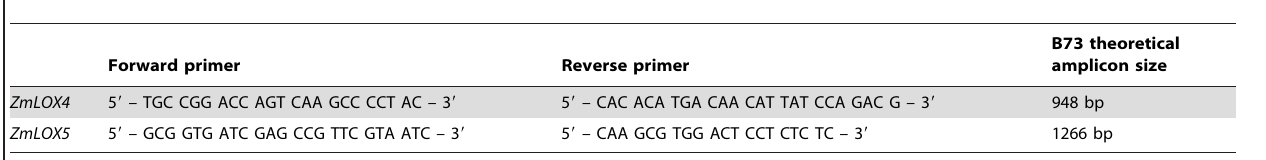
Table 2. Gene specific PCR primers and expected amplicon